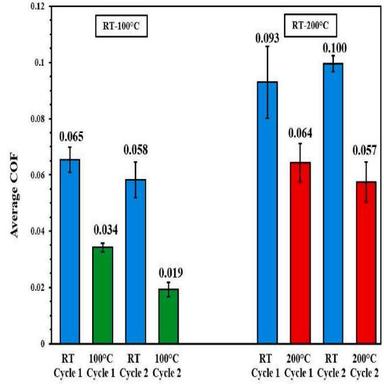
Average COF results from tunability study of cycle experiments at RT, 100, and 200 ◦C.